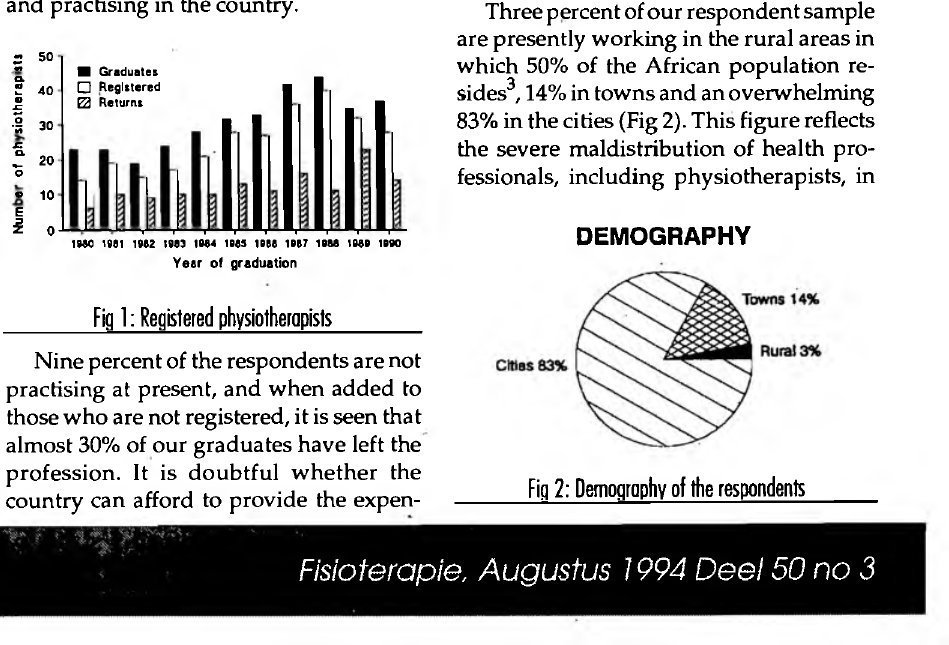
Fig 2: Demography of the